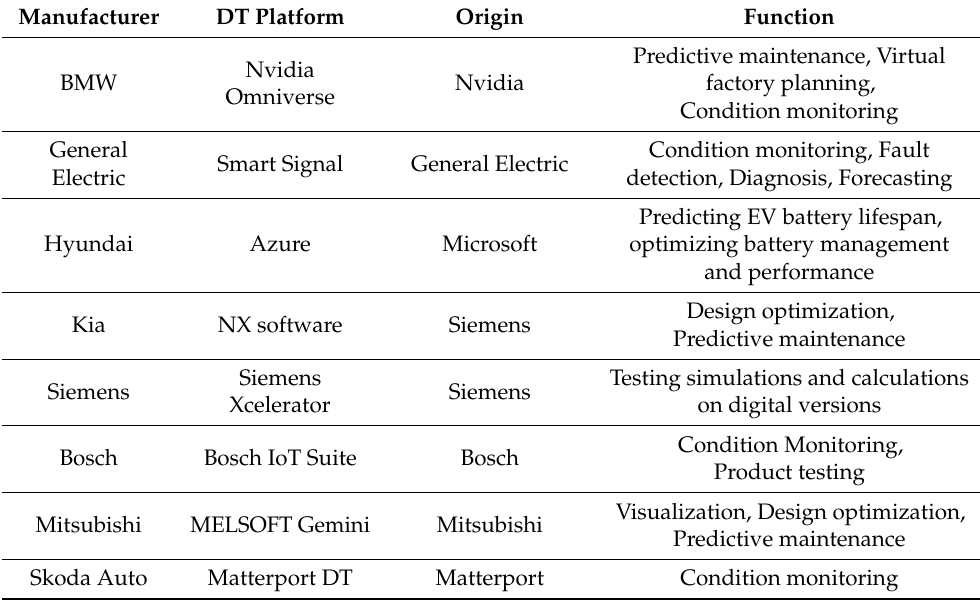
Table 2. Some DT platforms of EV manufacturers and their